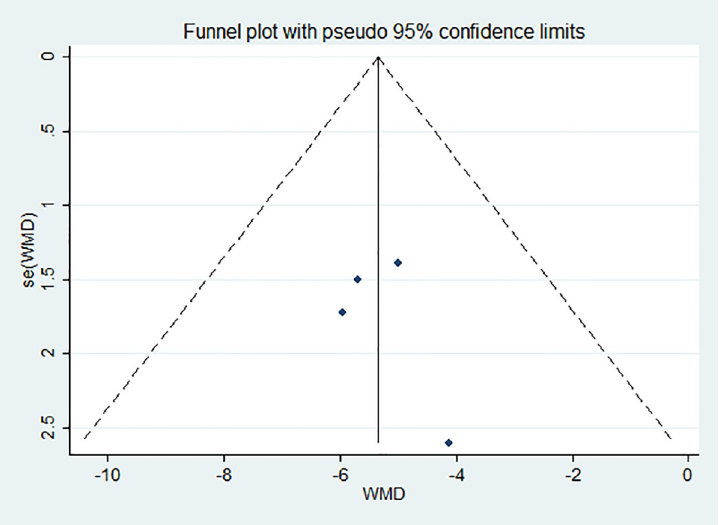
Fig 6. Publication bias among the papers. The bilirubin level of the case group was not concentrated in the 15–20 mg/dl range.